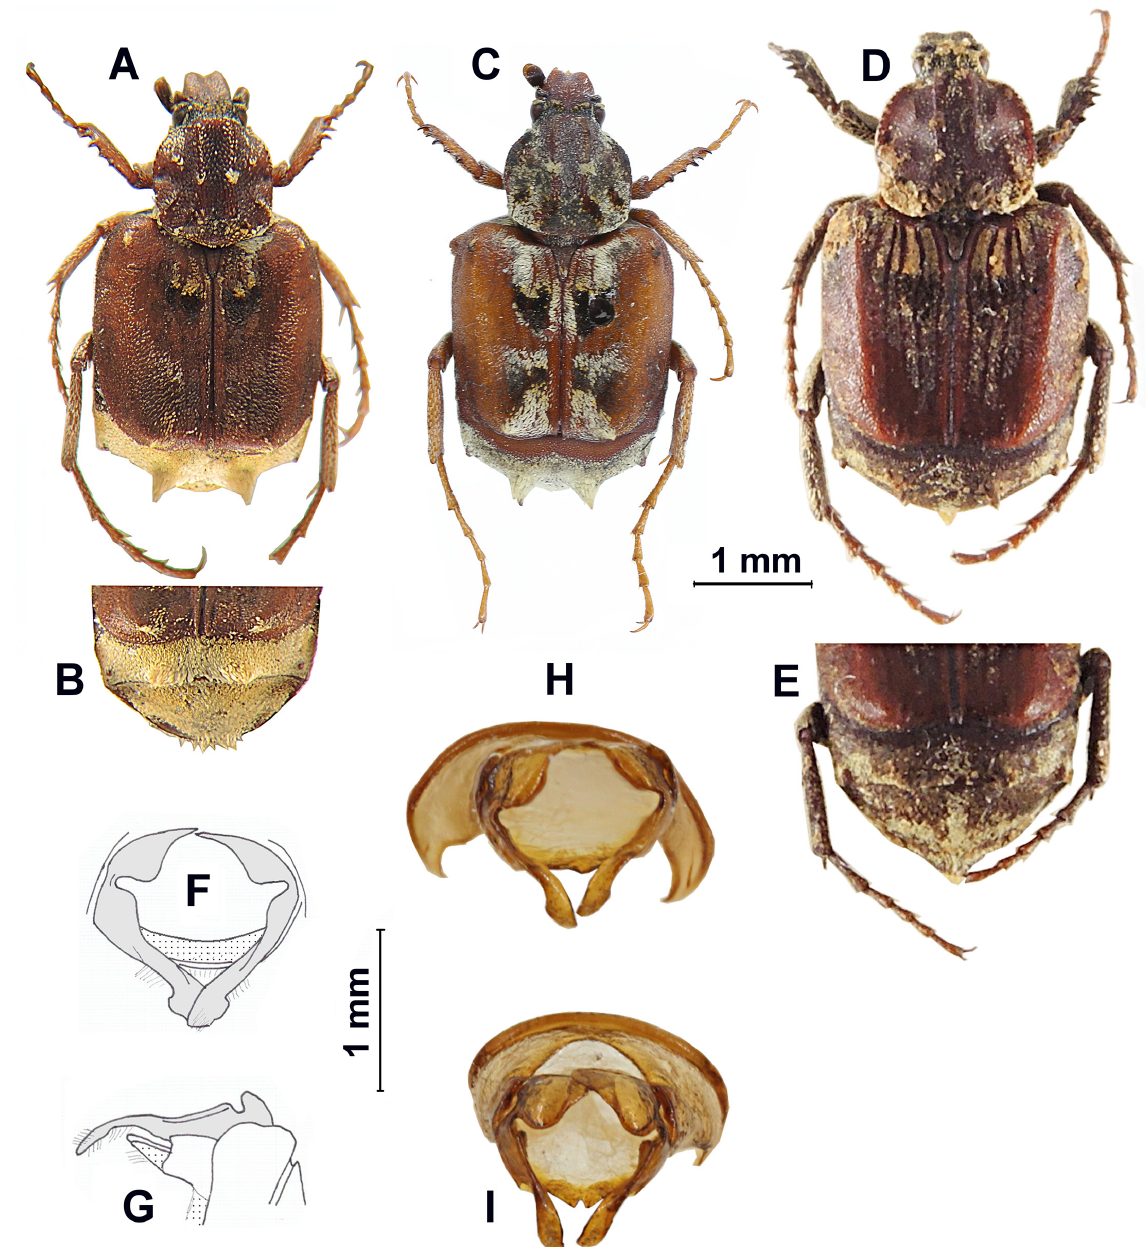
Fig. 7. A–C . Hybovalgus fraternus Moser, 1904. A–B . ♂ (ERC). A . Habitus, dorsal view. B .